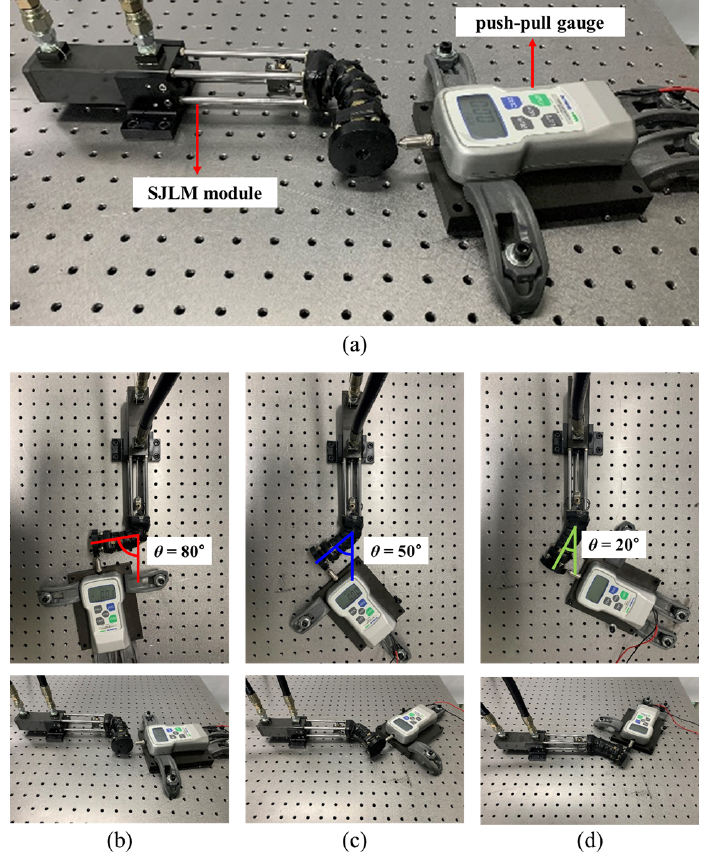
Figure 6. The experimental setup to substantiate the input( F ten )–output( F gen ) relationship: ( a ) the testbed consists of the SJLM module and a push–pull gauge; ( b – d ) are experimental setups for θ = 80 ◦ , θ = 50 ◦ , and θ = 20 ◦ , respectively. φ was set to 45 ◦ for all conditions.